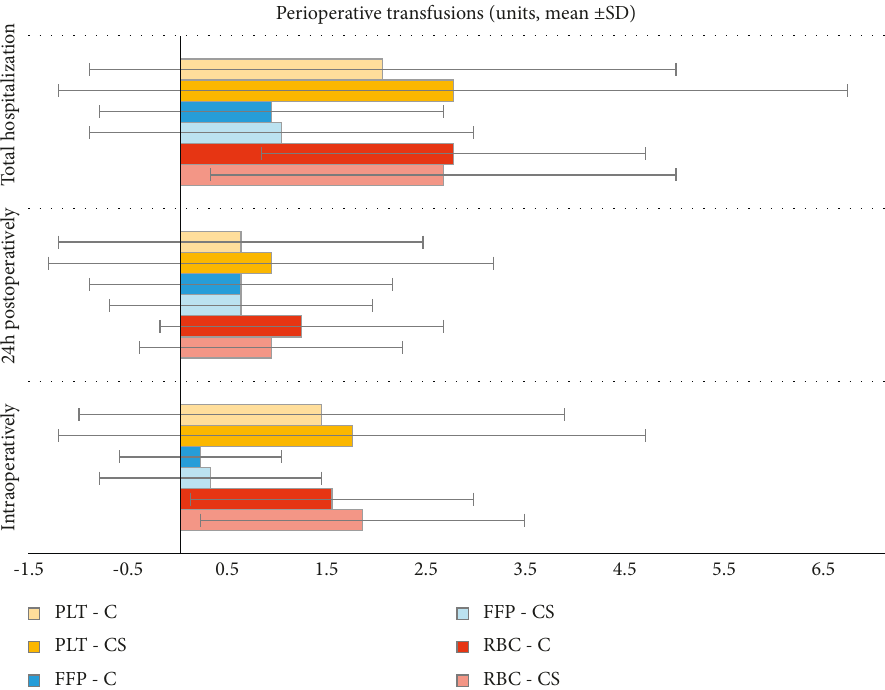
Figure 2: Perioperative transfusions (FFP: fresh frozen plasma, PLT: platelets, RBC: red blood cells, ( f ) : fisher’s exact